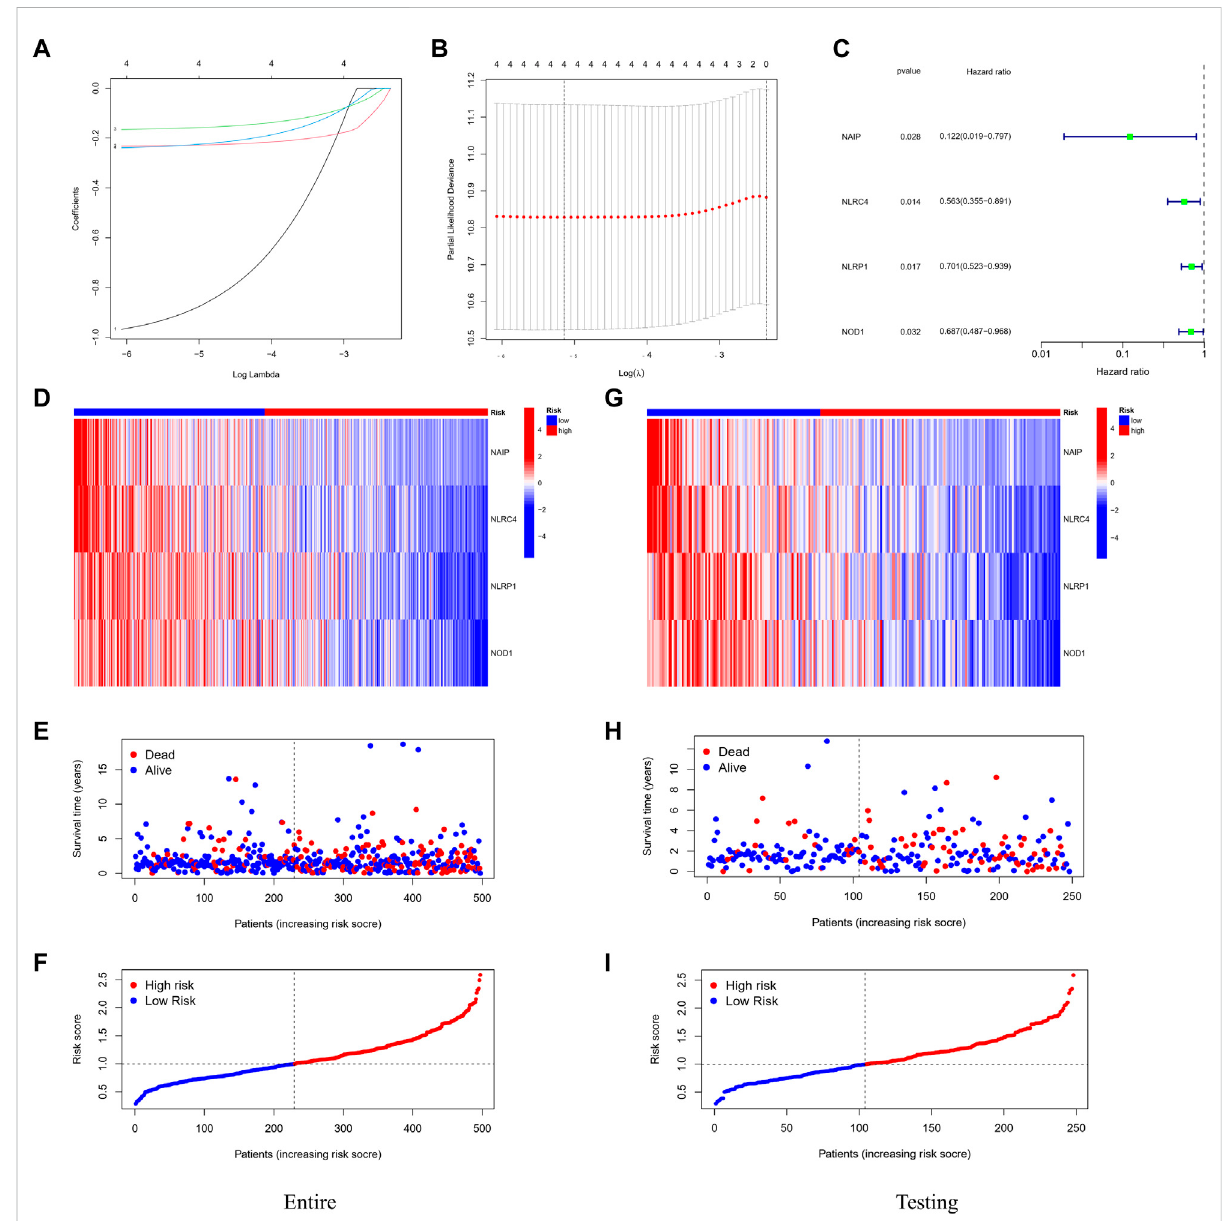
FIGURE 3 Construction of the prognostic strati fi cation model. (A) LASSO coef fi cient pro fi les. (B) Four candidate genes obtained by LASSO regression. (C) Four optimal genes obtained by multivariable Cox regression analysis. (D) Expression pattern of the four optimal genes between tumor and normal specimensintheentiredataset. (E) Survivalstatusforeachpatient(low-riskpopulation:ontheleftsideofthedottedline;high-riskpopulation:onthe right side of the dotted line). (F) Distribution of patients based on the risk score. (G – I) Expression pattern of the four optimal genes; survival status and distribution of patients based on the risk score between tumor and normal specimens in the testing